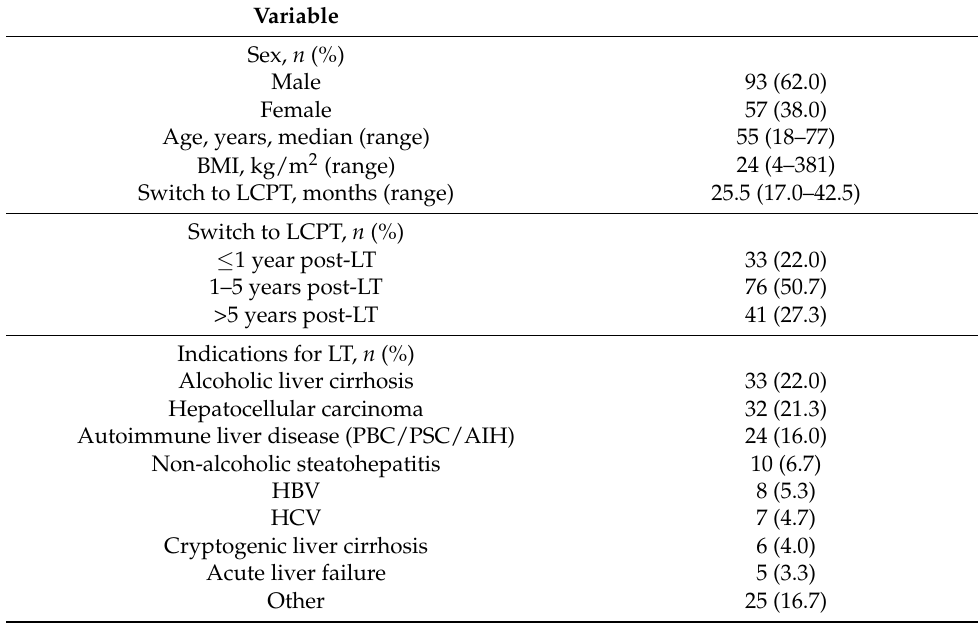
Table 1. Baseline patient